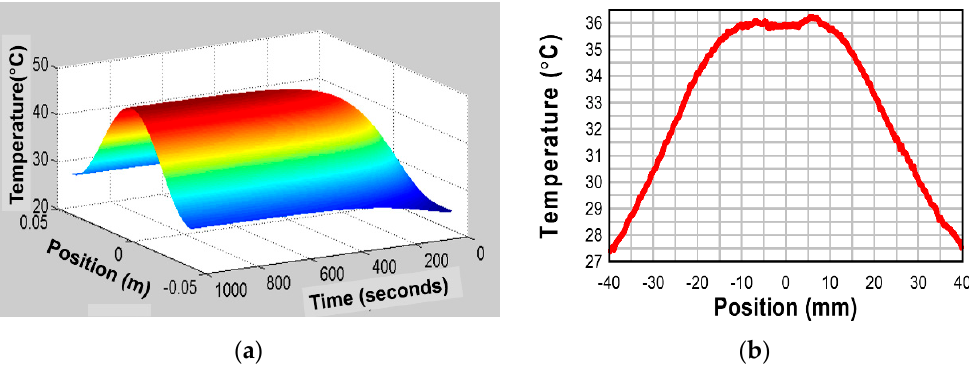
Figure 20. ( a ) Temperature distribution profile change with time after driving; ( b ) the saturated temperature distribution profile for k 31 specimen with 80 × 14 × 2 mm 3 .